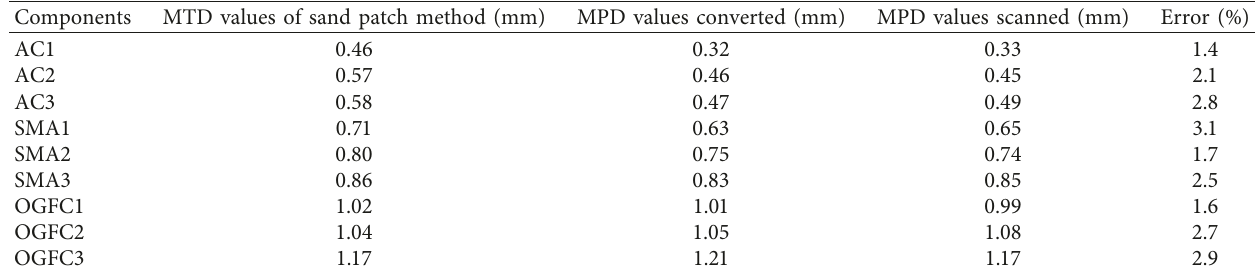
Figure 10: Variation curves of the adhesion coefficient with velocity: (a) AC pavement, (b) SMA pavement; (c) OGFC pavement. Table 2: MPD values of three kinds of asphalt